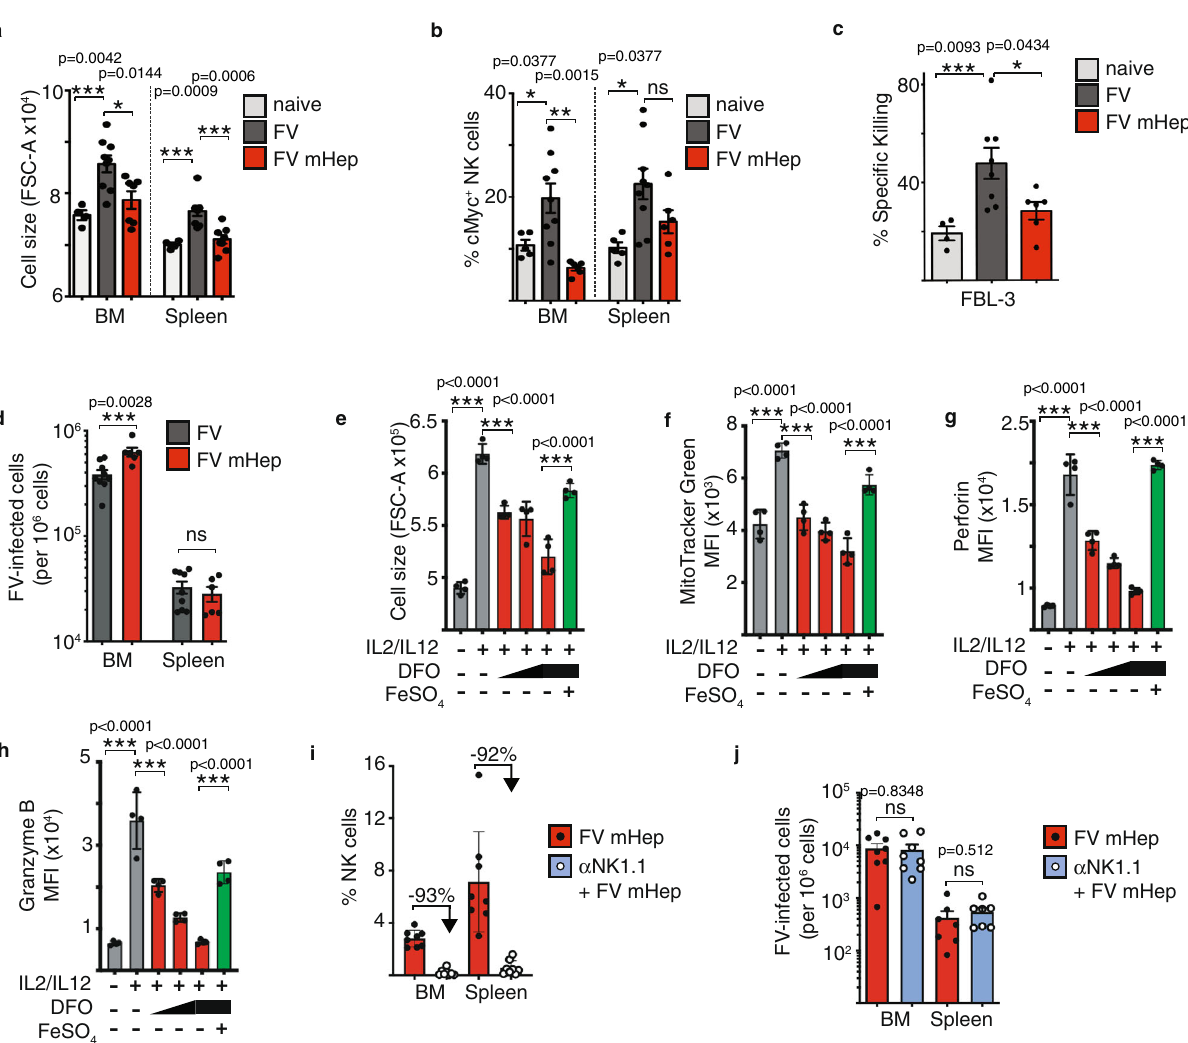
Fig. 7 In fl uence of low serum iron on NK cells during acute FV infection. C57BL/6 mice were infected i.v. with FV for 7 days or used as uninfected, naive control. Mice were treated every day i.p. with DSPE (vehicle) or mini-hepcidin (mHep) in DSPE. At the day of the experiment, bone marrow (BM) and spleens were harvested and stained for analysis by fl ow cytometry. NK cells were analysed for cell size (FSC, a ) and for cMyc ( b ). NK cells were isolated from spleens of naive + vehicle and FV-infected mice (FV + vehicle and FV + mHep) and co-incubated with Tag-it-Violet stained FV-induced FBL-3 tumour cells. After co-incubation, co-culture was stained for viability and analysed by fl ow cytometry ( c ). Viral loads were detected by an Infectious Center assay in bone marrow and spleen and analysed by a two-sided Mann – Whitney test ( d ). At least fi ve mice per group from two independent experiments were used. Statistically signi fi cant differences between the groups were analysed with an Ordinary one-way ANOVA ( a – c ). The cell culture medium of in vitro expanded NK cells was modi fi ed for iron availability (DFO) and additional iron (FeSO 4 ) was added if indicated. NK cells were analysed for cell size ( e ), MitoTracker Green ( f ), perforin ( g ) and granzyme B ( h ). Experiments were performed once with four biological replicates. Statistically signi fi cant differences were analysed by an ordinary one-way ANOVA with a Sidak post-test. NK cells (NK1.1 + CD4 − CD8 − ) were depleted with an anti-NK1.1 depletion antibody and depletion ef fi ciency is shown in i . At 3 dpi, viral loads of FV-infected, mHep-treated ± NK cell depletion is displayed in j and were analysed by a two-sided unpaired t -test. All data are presented as mean values ± SEM. * p < 0.05, ** p < 0.01, *** p < 0.001. Source data are provided as a Source Data fi le. ns not signi fi